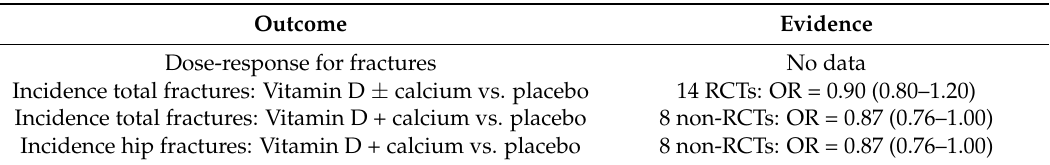
Table 4. Evidence for relationship between vitamin D exposure and fractures: Example of good-but-not-strong evidence 1 .